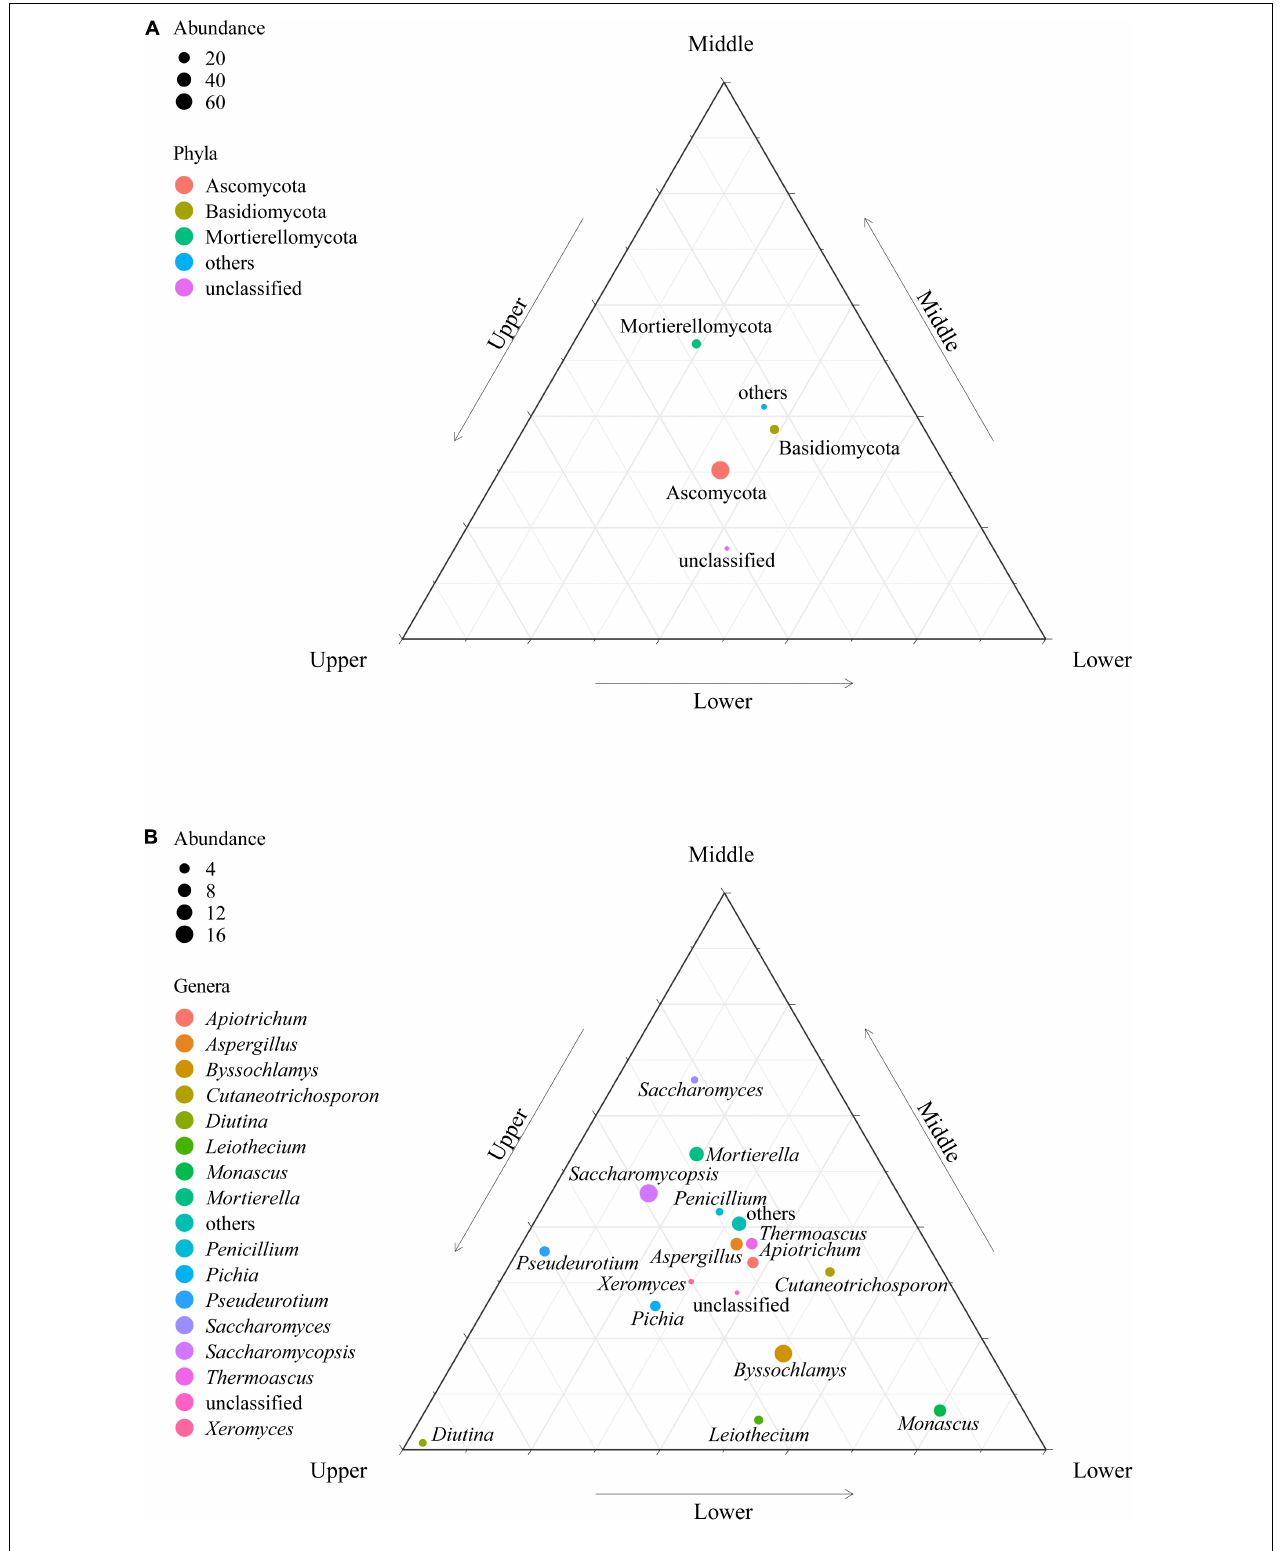
FIGURE 3 | Fungal composition of PM samples at the level of phylum (A) and genus (B) .